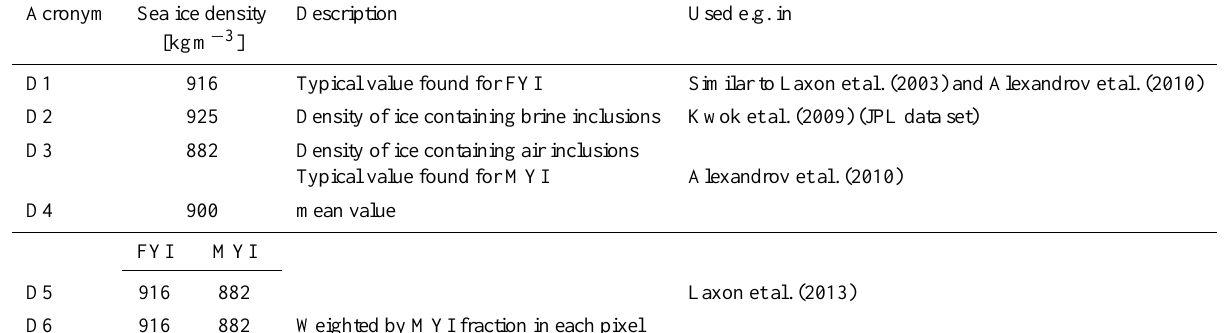
Table 3. Different assumptions about sea ice density as used in this study to assess the possible range of sea ice thickness.